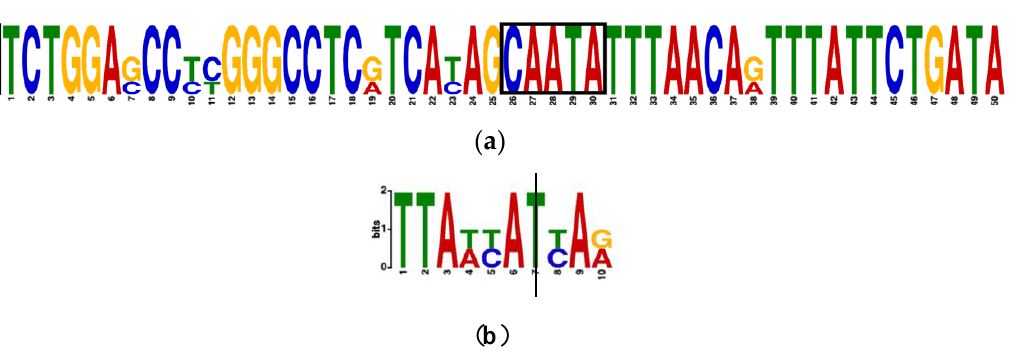
Figure 5. Motif conservation of genes GPR88 and WNT7A among humans, mice, and rats. Each graph obtained from MEME represents a motif discovered. ( a ) The motif in WNT7A 50 nucleotides long, with the boxed nucleotides at position 13818650–13818646 in reverse complement order. ( b ) The 10-nucleotide long motif containing the SNV at position 100541492 is in GPR88, conserved only among humans and mice.